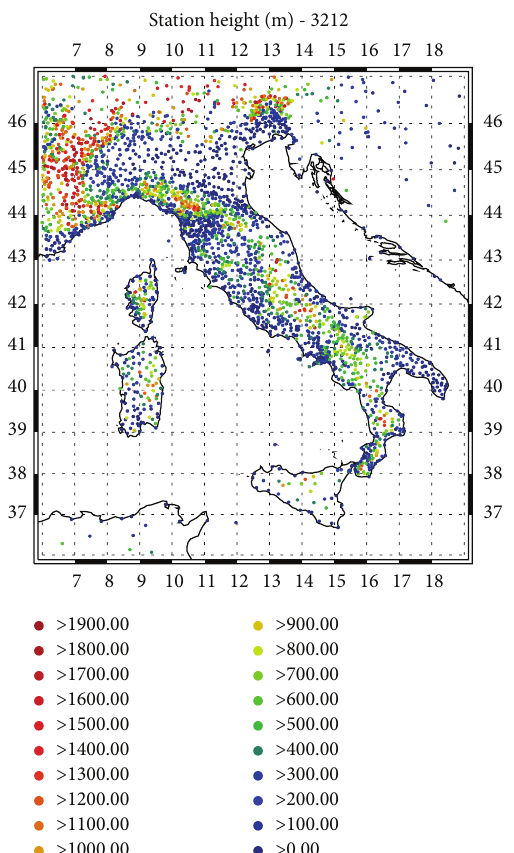
Figure 1: Rain gauges considered in this study. The colours are the rain gauges heights in metres.